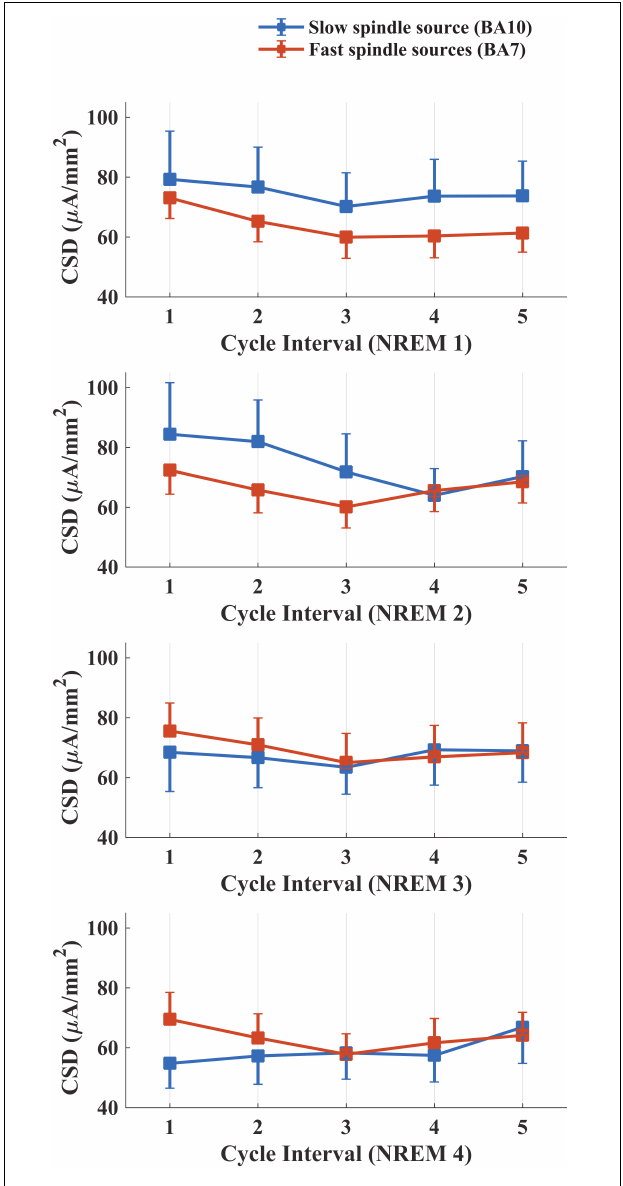
FIGURE 4 | Temporal evolution of mean CSD in BA10 (blue line) and BA7 (orange line) across intervals within each NREM sleep